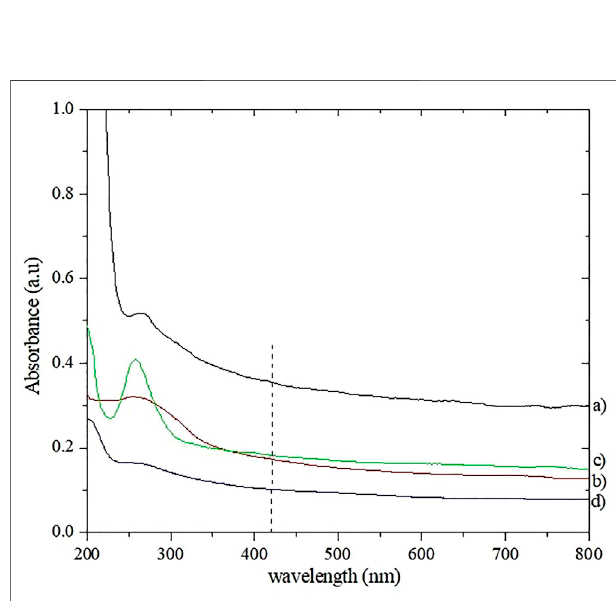
FIGURE 3 | UV-visible spectra: (A) fCNT; (B) fCNT/TiO 2 (36)500 ° C.20; (C) fCNT/ZrO 2 (36)500 ° C.20; (D) fCNT/TiO 2 .ZrO 2 (36)500 °